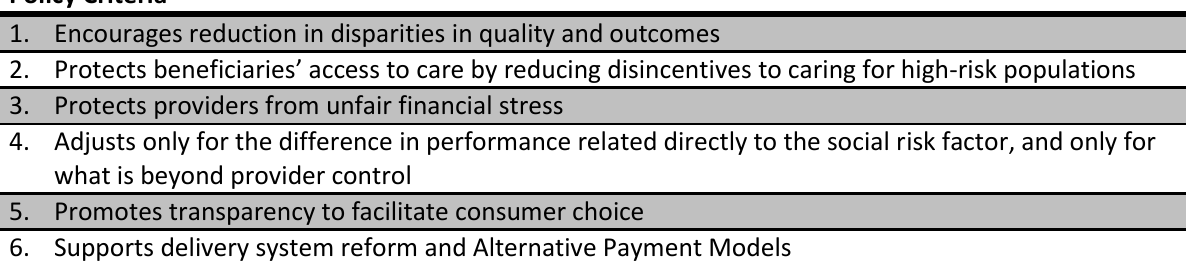
Table 11.9: Policy Criteria Policy